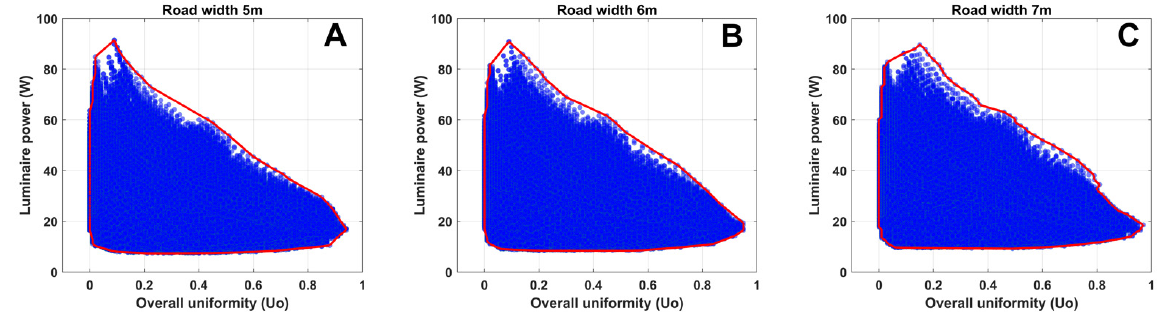
Figure 3. Overall uniformity of illuminance vs. required luminaire power for E m = 10 lx. The graphs include all potential pole arrangements, as shown in Table 1: ( A ) results for road width of 5 m; ( B ) results for road width of 6 m; ( C ) results for road width of 7 m.